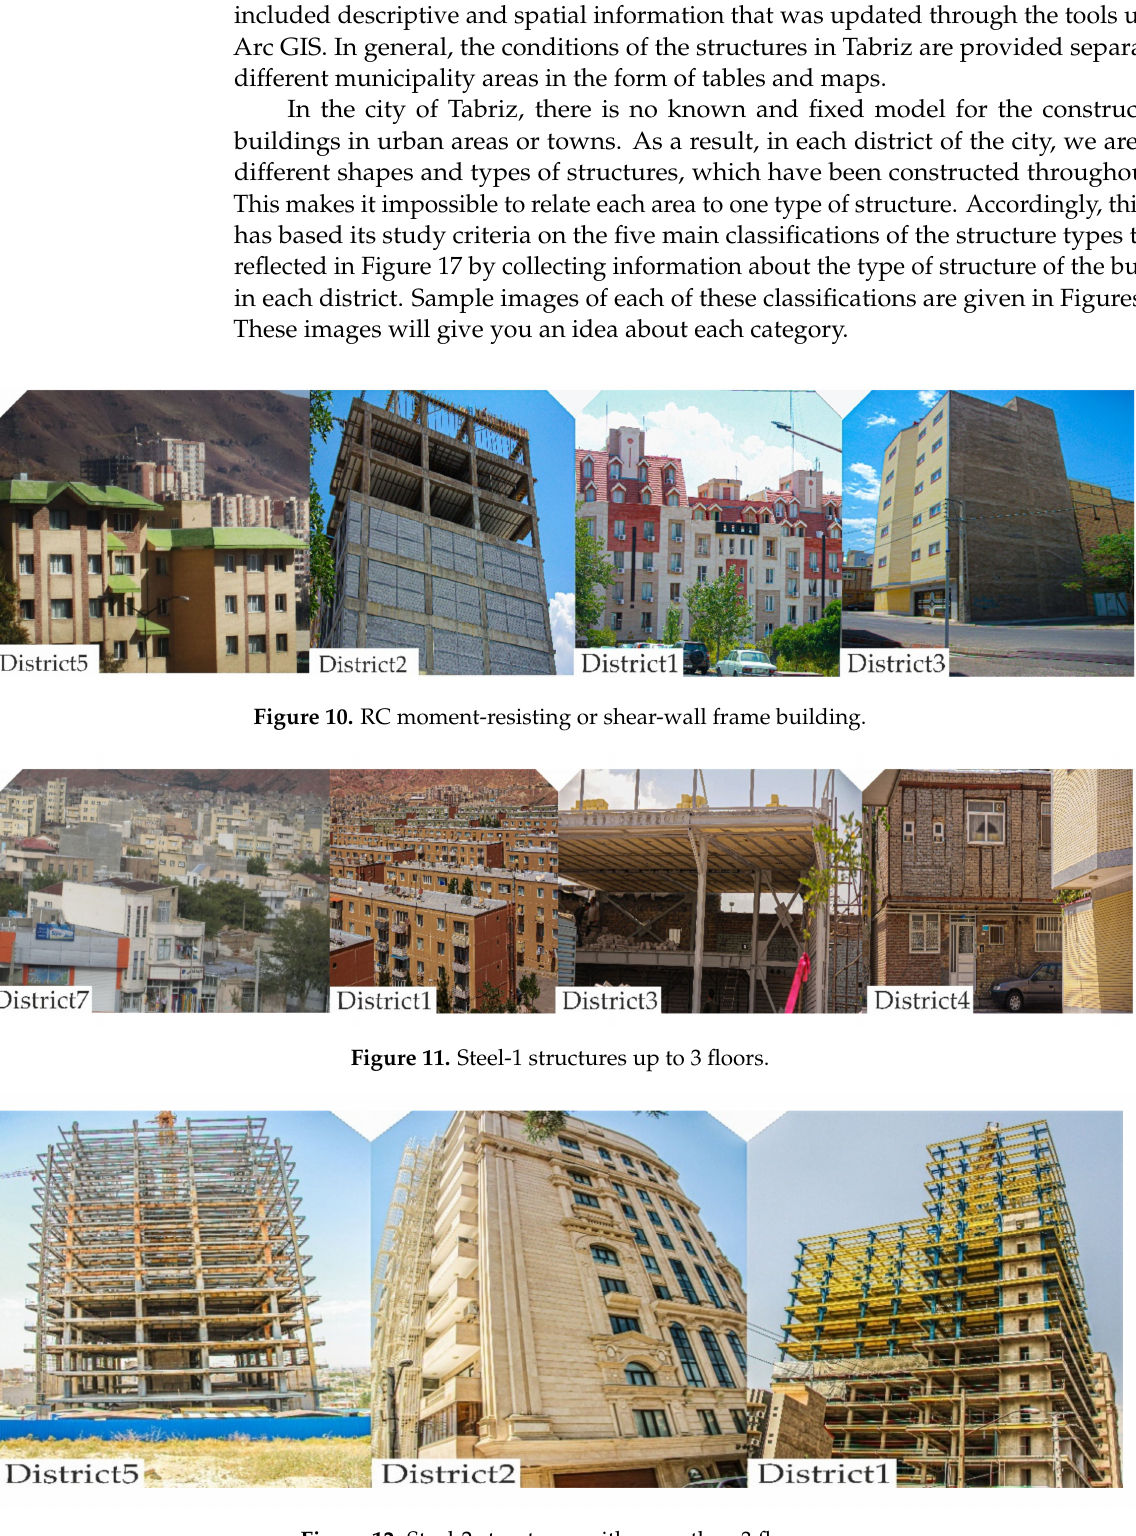
Figure 12. Steel-2 structures with more than 3